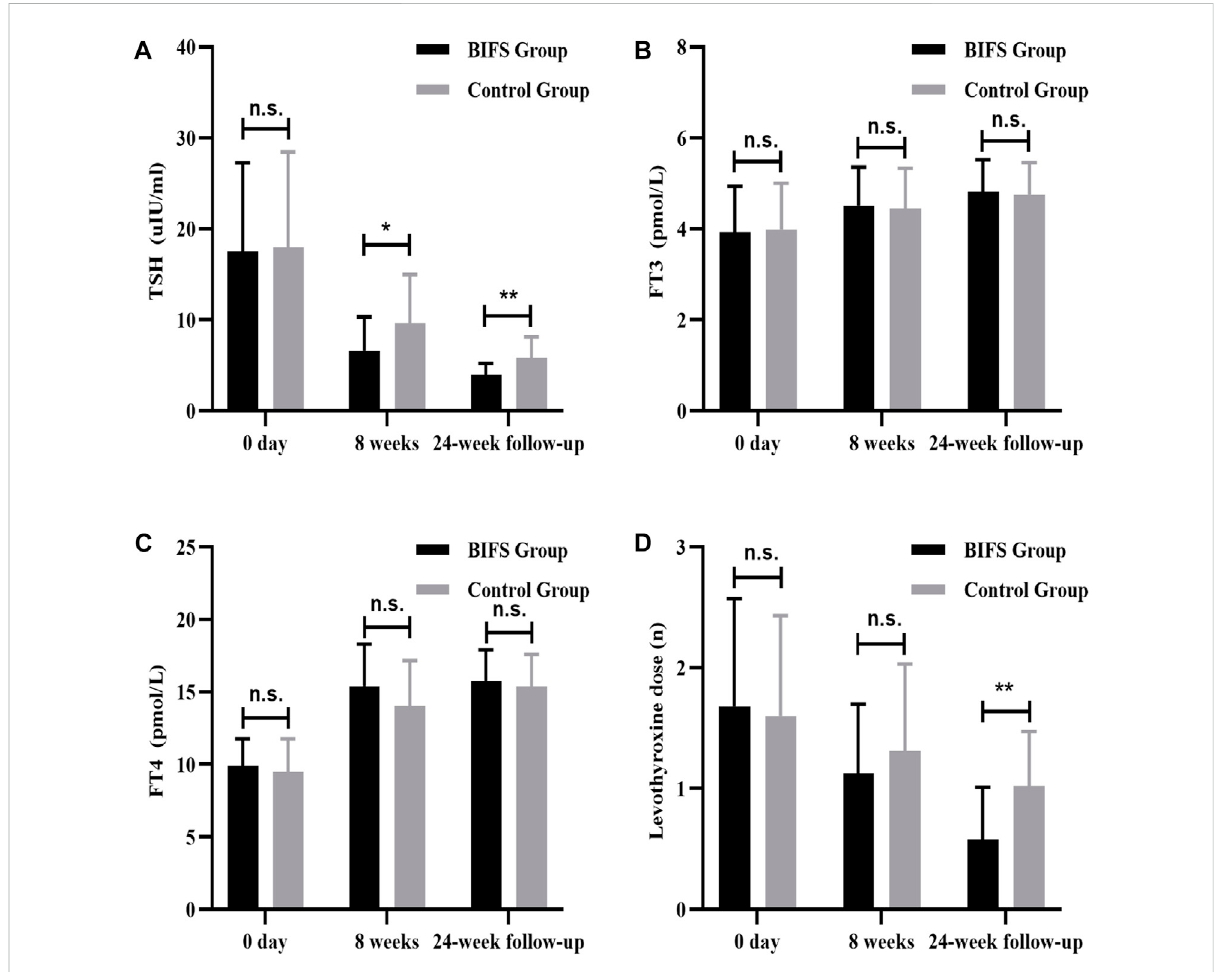
FIGURE 5 TSH, FT3, FT4, and levothyroxine levels at baseline, after eight treatment weeks, and at 24-week follow-up. (A) TSH level; (B) FT3 level; (C) FT4 level; (D) levothyroxine dose; n.s., no statistically signi fi cant difference; * p < 0.05; ** p <